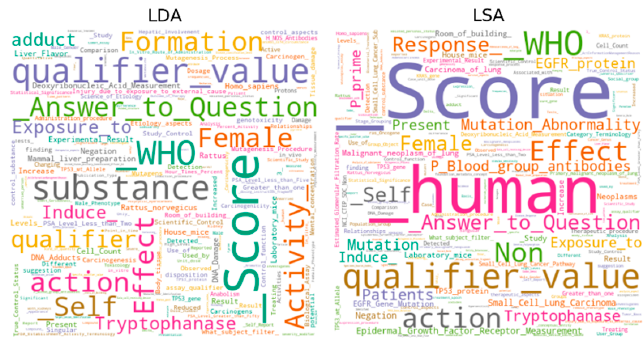
Figure 8. Word cloud of the top-1 topics on the GIM hallmark.